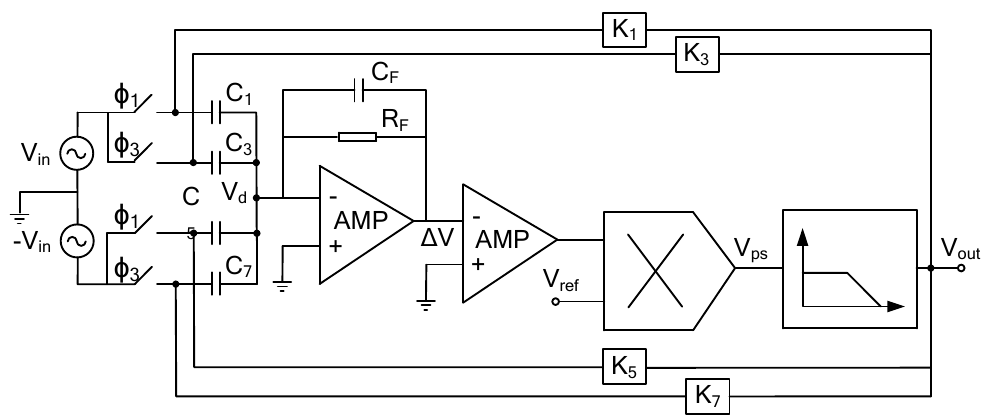
Figure 7. Schematic of the single path detection principle of micro gyroscope with ball-disc rotor. The charge-voltage conversion circuit structure of the transimpedance structure is shown in Figure 8. In order to improve the open-loop gain, a three-stage folded cascode structure is used in the operational amplifier. Through the analysis of its structure, the equivalent input noise density is